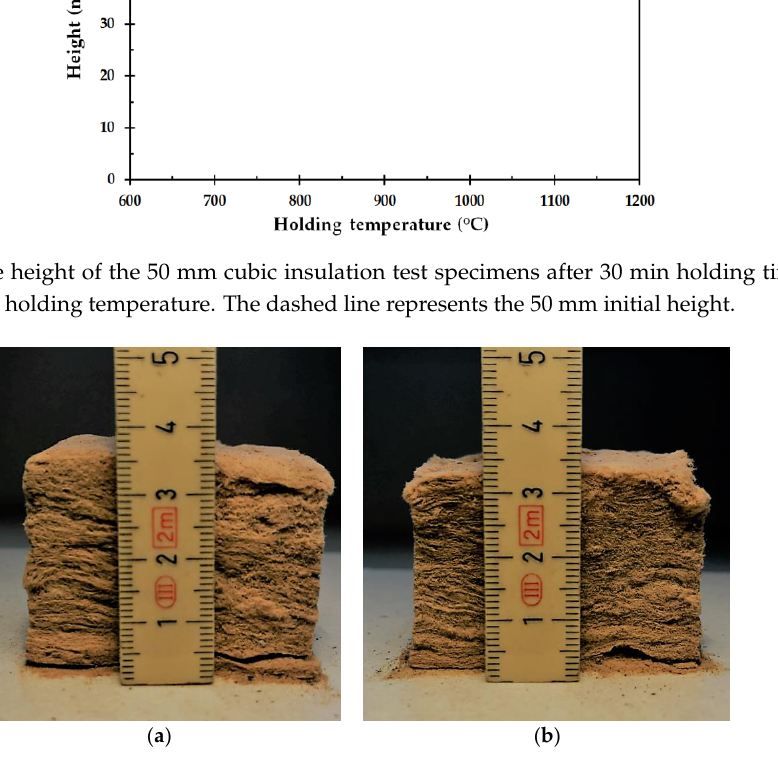
Figure 13. Test specimens (50 mm cubes) after 30 min heat exposure at 1100 ° C for ( a ) test a and ( b ) test b.